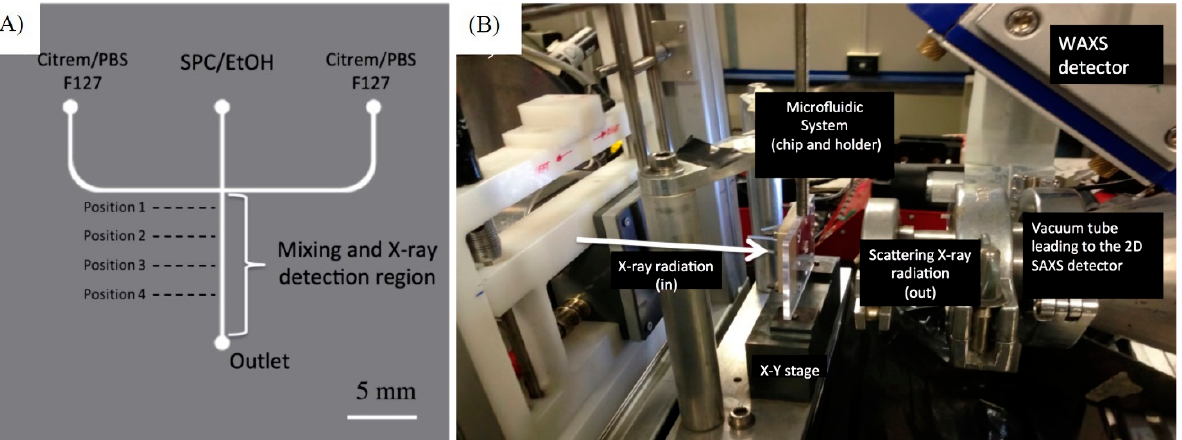
Figure 3. ( A ) Schematic illustration of an X-ray-compatible HFF microfluidic device for in situ SAXS characterization of lipid nanoparticles at 4 different positions along the microchannel. ( B ) Synchrotron SAXS set-up employed by coupling SAXS to an X-ray-compatible HFF microfluidic device for in situ characterization studies. The figure is reprinted with permission from [30]. 2017, the Royal Society of Chemistry.